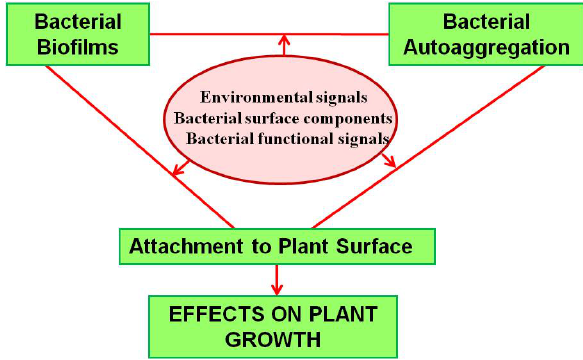
Figure 1. Bacterial autoaggregation and biofilm development, and their relationship with plant colonization. Cell aggregation and biofilm formation in plant-bacterial associations are regulated by environmental signals, nutrient limitation of growth, quorum sensing, EPSs, flagella, LPSs, and other